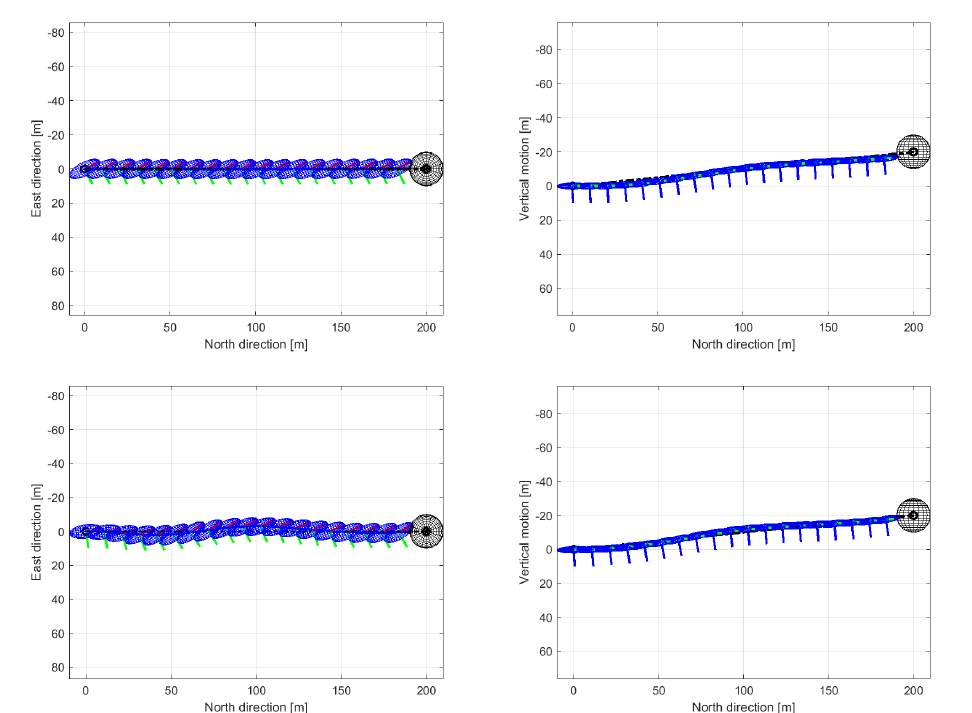
Figure 17. Trajectory views in the presence of a western wind of 3 m/s, considering the same target track and checkpoint of Figures 11 and 12. Ground speed setting of 6 m/s. ( Top ) baseline airship. ( Bottom ) four-thrusters thrust-controlled airship. ( Left ) top view. ( Right ) view from the east. Black dash-dotted lines: target track. Black spheres: target checkpoint capture